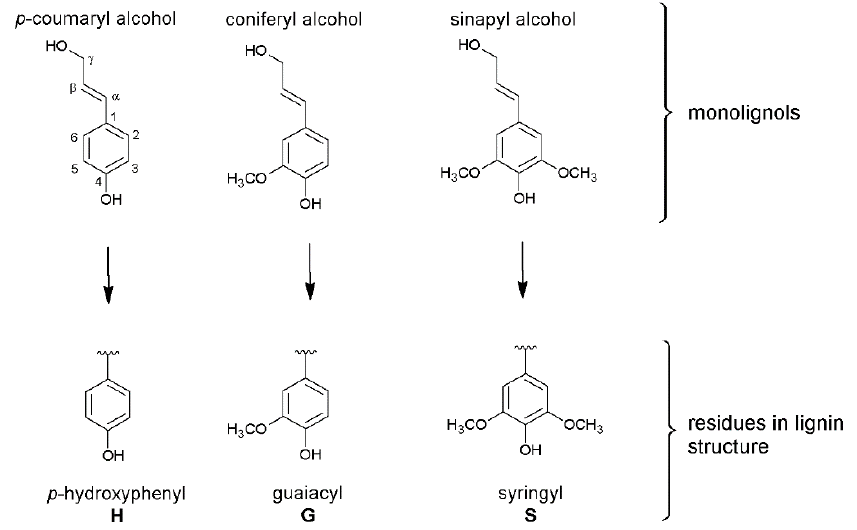
Figure 4. Lignin monolignol structures: p-coumaryl alcohol, coniferyl alcohol, and sinapyl alcohol forming the specific residues p-hydroxylphenyl (H), guaiacyl (G), and syringyl (S) [140].